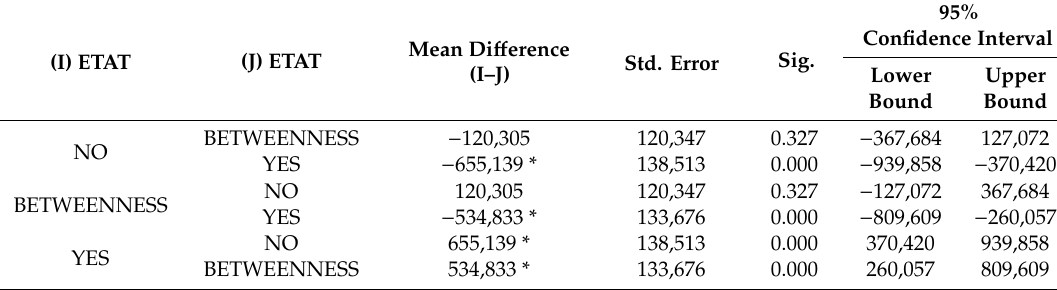
Table 5. Post hoc tests: Multiple comparisons